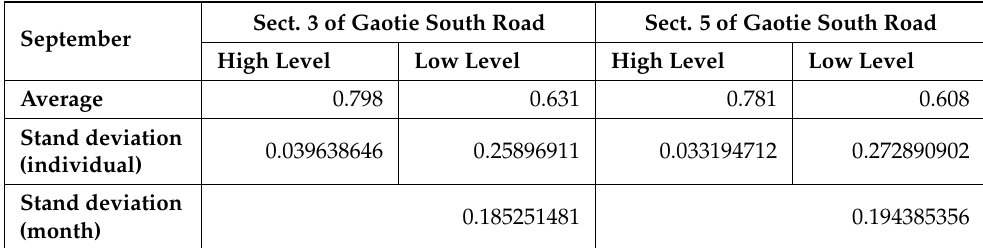
Table 8. The standard deviation of luminance longitude uniformity.